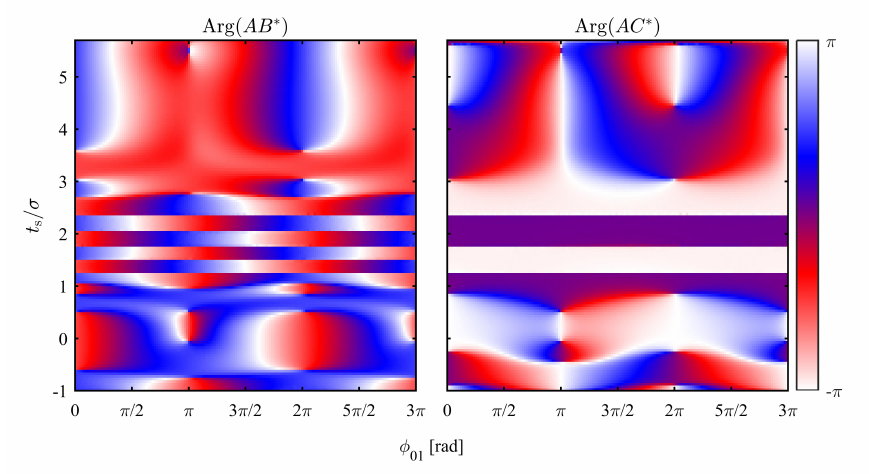
Figure 5. The relative phases between the complex amplitudes A , B , and C of the qutrit as a function of the dimensionless STIRAP pulse separation t s / σ and the STIRAP phases φ 01 and φ 12 . The STIRAP phases are changed so that 2 φ 01 + φ 12 = 4 π . When the adiabatic condition t s / σ ∈ [ 1,3 ] is met, the relative phases are given by Equations (20) and (21) , resulting in the formation of a stripe structure. The abrupt π phase shifts across the stripes are due to the changes of sign of the amplitudes, as can be seen from the sin and cos terms of Equation (13). The parameters for the simulation ( 0 ) = Ω ( 0 ) = 37.5 MHz, σ = 50 ns, α = cos ( π /8 ) , and β = − i sin ( π /8 ) are Ω 01 12